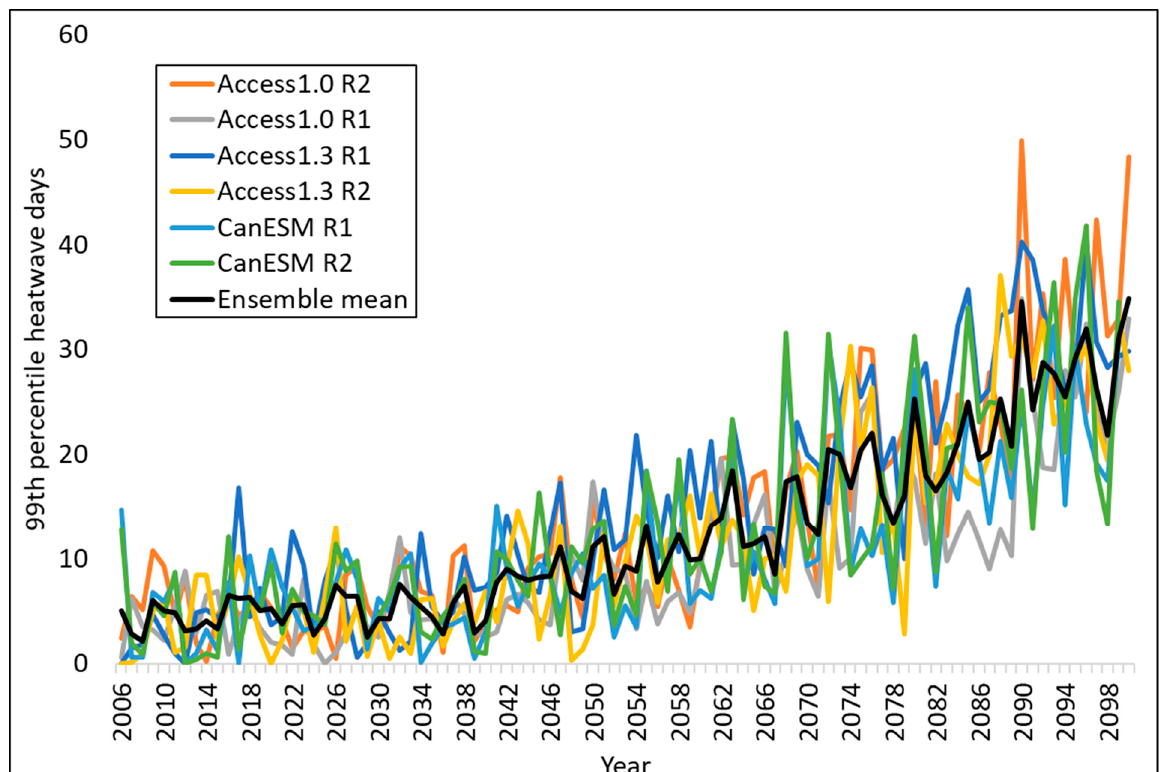
Figure 4. Future annual numbers of heatwave days exceeding the 99th percentile 24 h temperature threshold for at least two consecutive days from the period 1986–2005; heatwave days were flagged for the global climate model (GCM) ensembles CSIRO-BOM ACCESS1.0, CSIRO-BOM ACCESS1.3 and CanESM2 based on the physical configurations of the weather research and forecasting (WRF) models R1 and R2. The ensemble mean is shown as a black line.